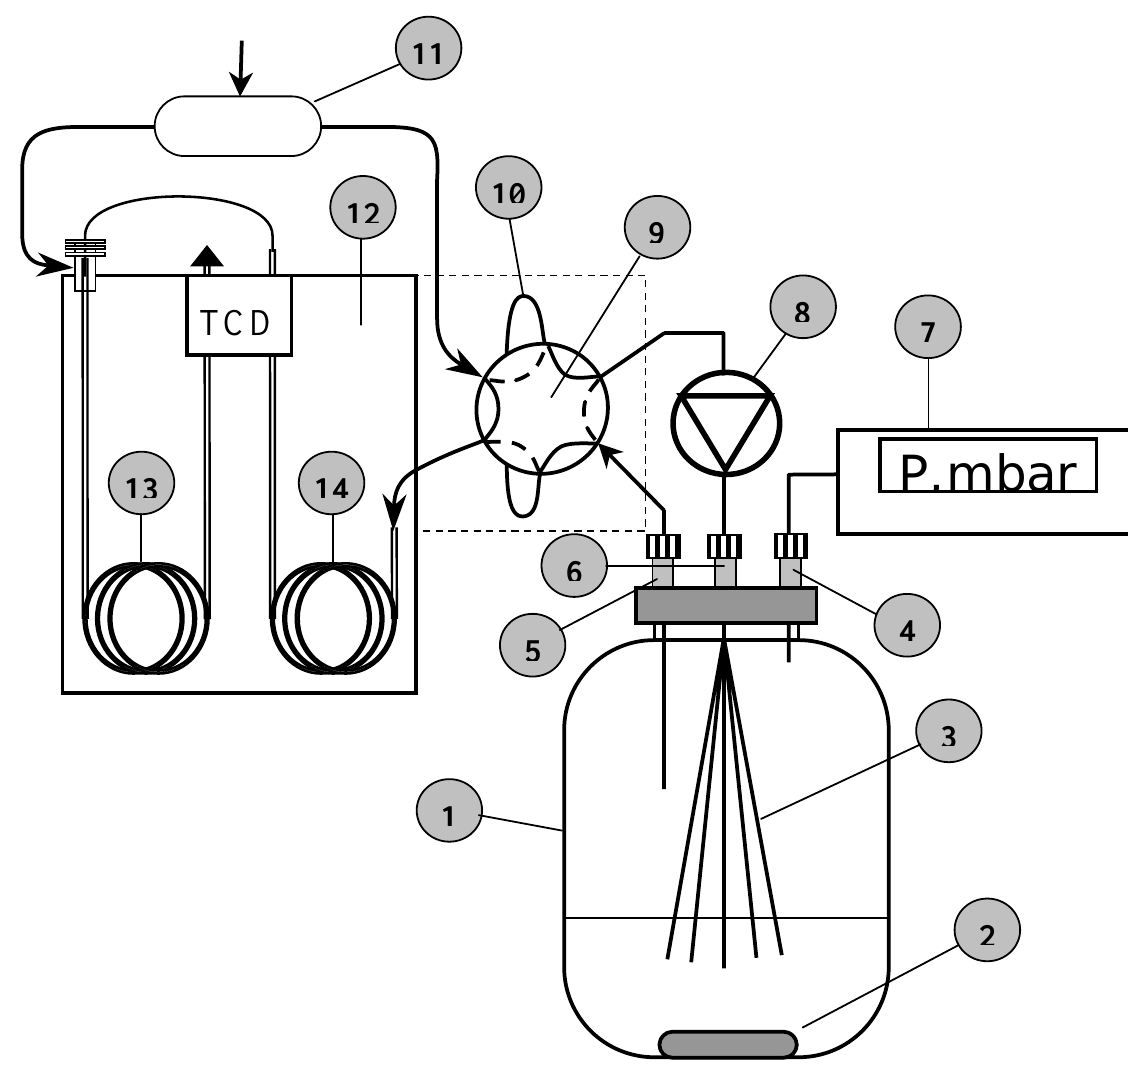
Figure 6. Scheme of the device used for head-space analysis of gas phase under quercetin solu- tion during oxidation by air oxygen: 1 – vessel with solution; 2 – magnetic stirrer; 3 – gas tubes; 4 – manometer connection; 5 – gas outlet connection; 6 – gas inlet connec- tion; 7 – digital pressure meter; 8 – circulating pump; 9 – heated gas injection valve; 10 – gas sampling loop; 11 – carrier gas supply; 12 – gas chromatograph; 13 – packed column with molecular sieves (zeolites); 14 – packed column with Porapak